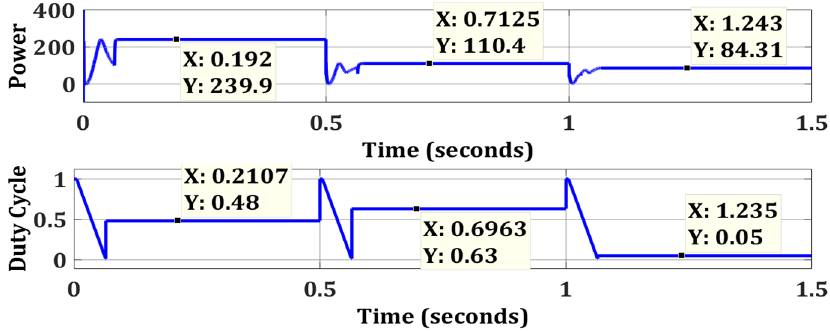
Figure 17. Changing weather conditions for 4S2P PV system configuration .